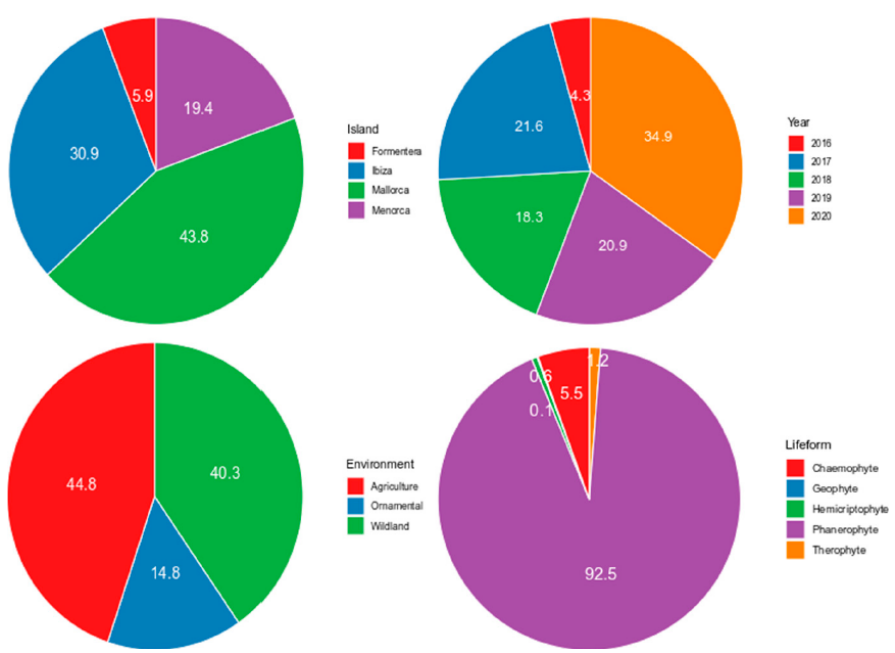
Figure 1. Sampling distribution for Xylella fastidiosa ( Xf ) over time, among islands, different environ- ments, and plant life forms.